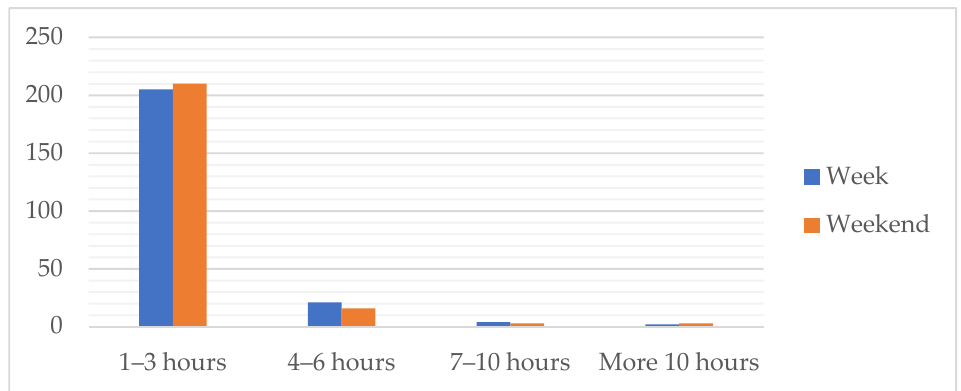
Figure 1. Distribution of the hours of play during the week and the weekend. 156 157